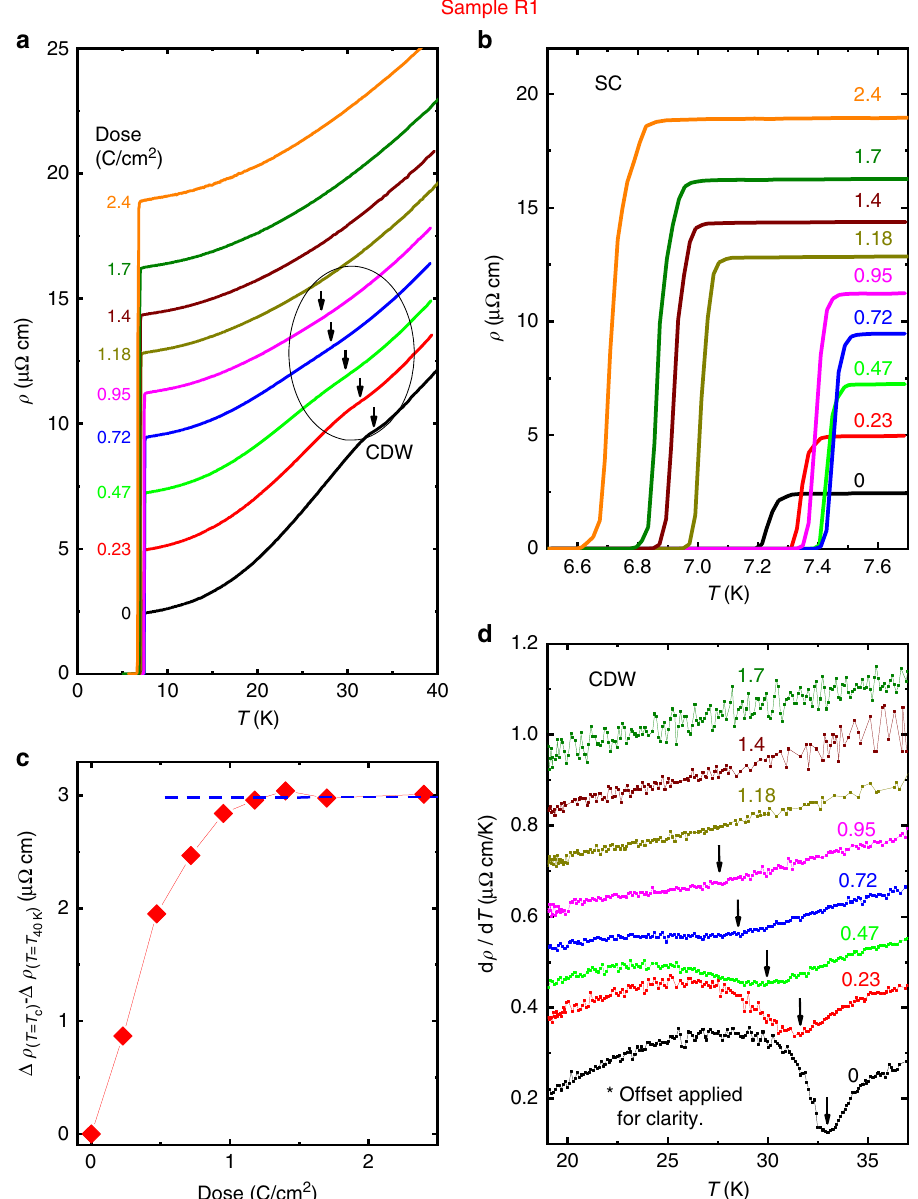
Fig. 2 Resistivity measurement conducted on sample R1. a The temperature dependence of resistivity upon irradiation. Overall, the resistivity above the CDW transition was parallel-shifted upward suggesting that preservation of Matthiessen ’ s rule only occurs above the transition (see text for further discussion). b The zoom of superconducting transition area shows the increase and subsequent decrease of T c upon irradiation. c Δ ρ ( T = 7.6 K ) − Δ ρ ( T = 40 K ) shows the disappearance of the CDW above 1.0 C cm − 2 . d The derivative of resistivity with respect to temperature manifests the location of the